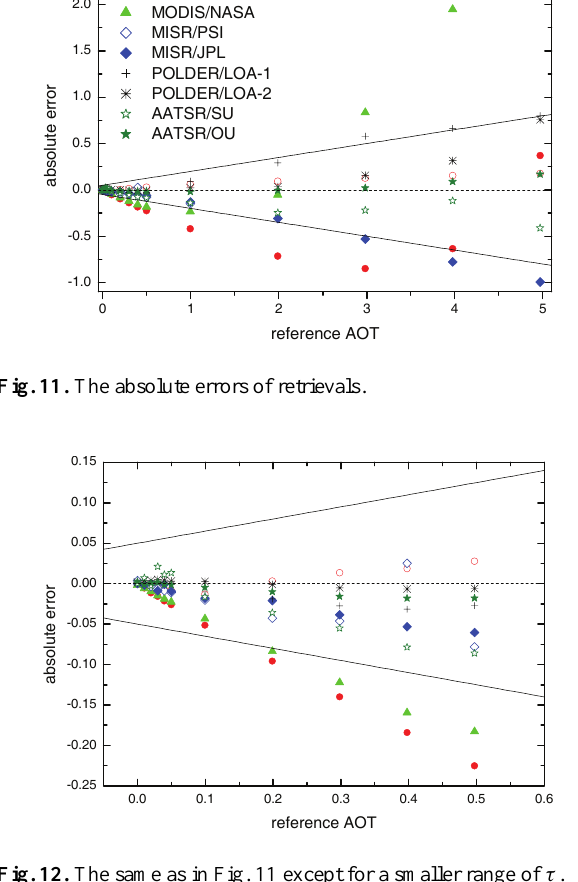
mostly due to the general decrease of information con- tent as resulted from the increased multiple scattering effects (smoothing of angular patterns in reflected